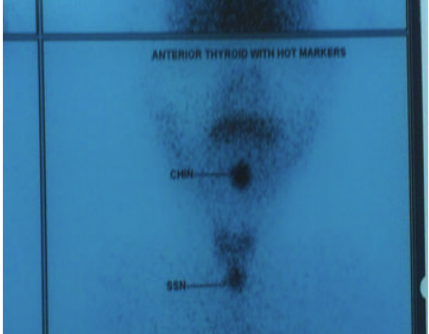
Figure 2: 99 m technetium pertechnetate scan. No abnormal tracer uptake was seen in the clinically palpable swelling at the base of the tongue.